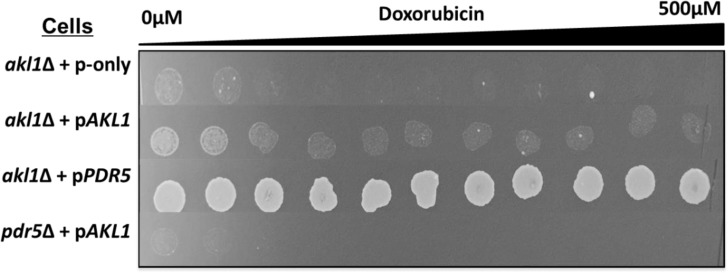

AKL1 overexpression analyses in pdr5Δ mutants.
AKL1 was overexpressed in haploid pdr5Δ mutants and doxorubicin resistance was tested by a spotting assay.